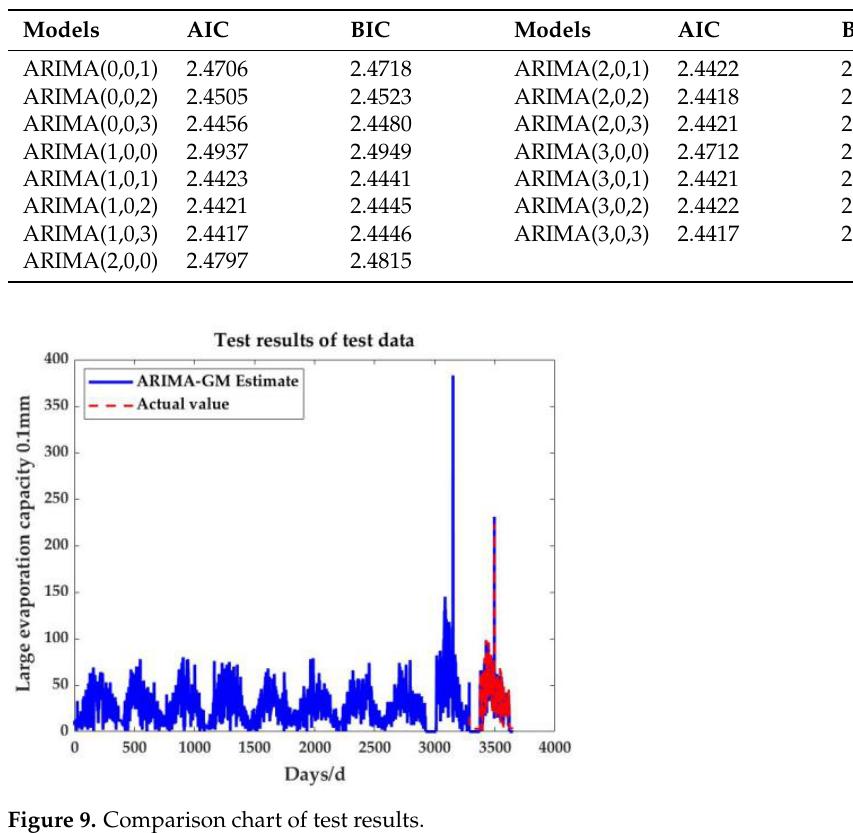
Table 2. AIC and BIC values for each model.